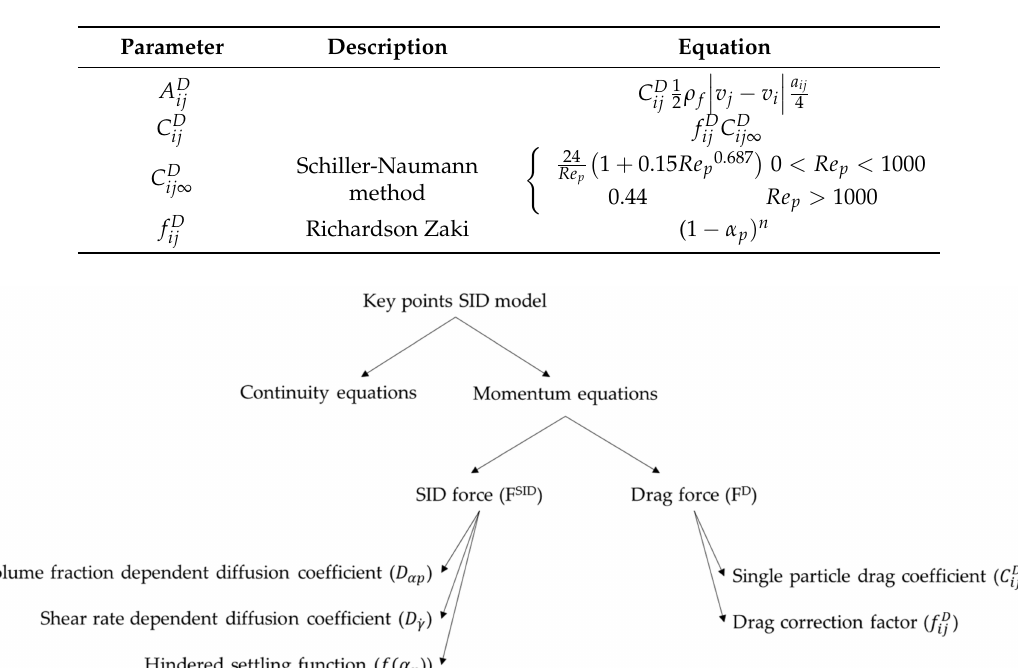
Table 2. Relations used for the drag force.